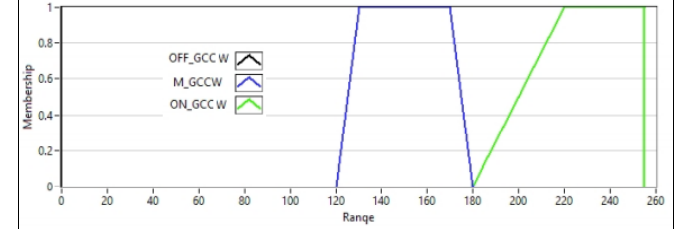
Figure 14: Graph of member functions of the Azimuthal movement motor.